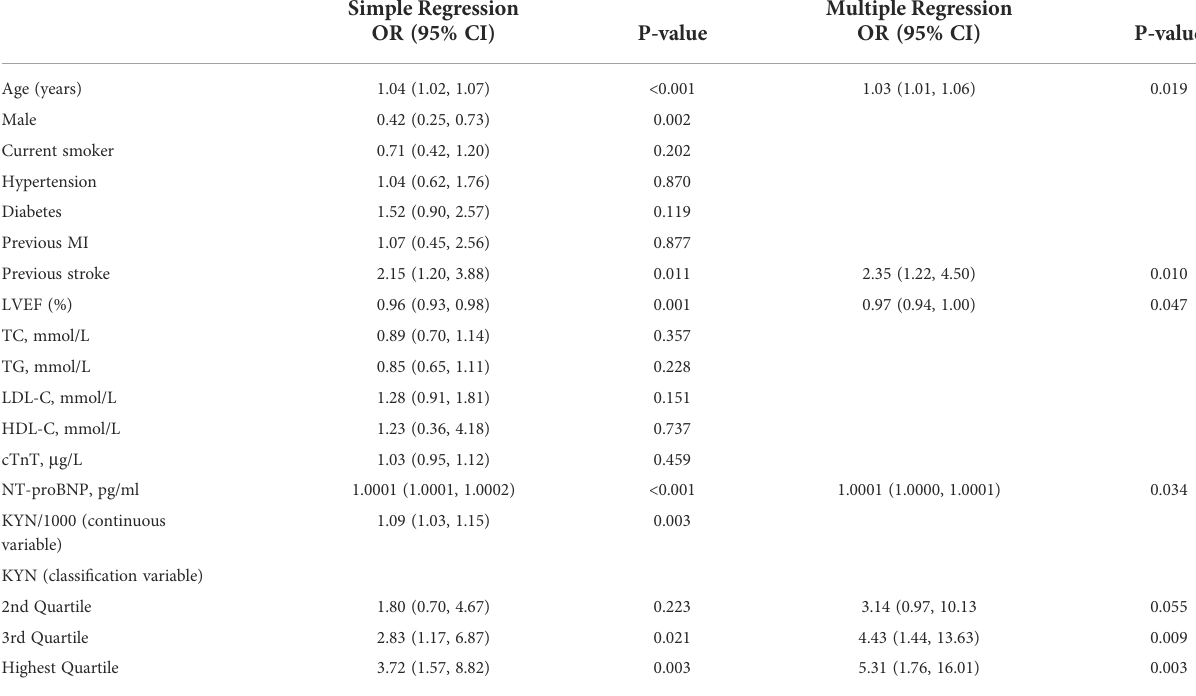
TABLE 4 Logistic Regression Analysis for MACE in Patients with STEMI. Simple